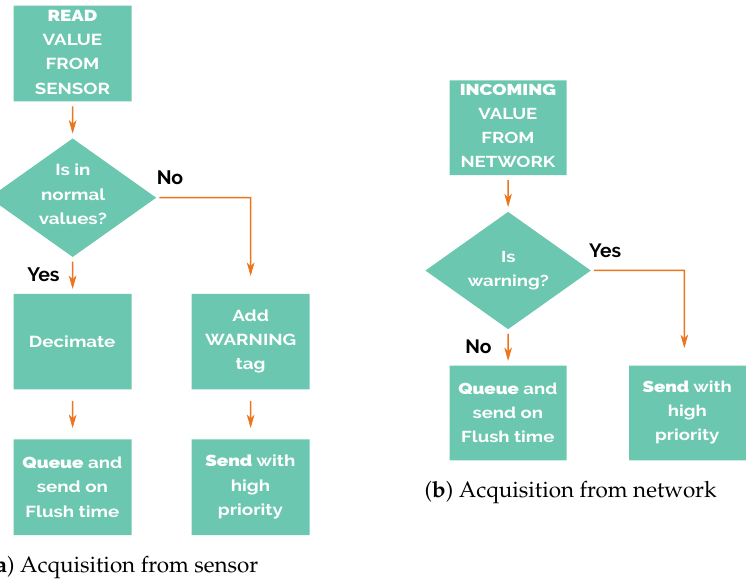
Figure 6. Acquisition